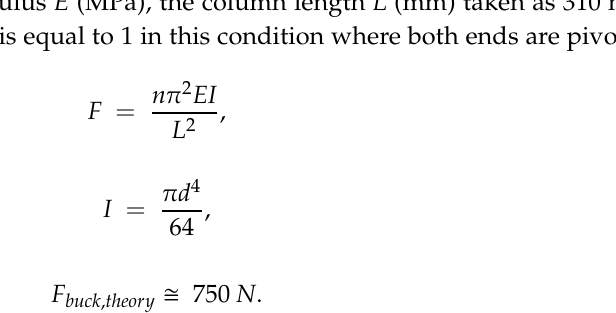
Figure 9. ( a ) Bottle geometry before and after simplification; ( b ) detail of geometry and mesh by shell elements; ( c ) application of forces and boundary conditions (case of non-linear static analysis).